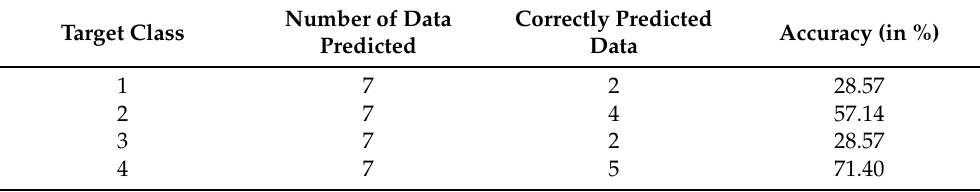
Table 5. Tested Predictions based on Nepal Earthquake Data.